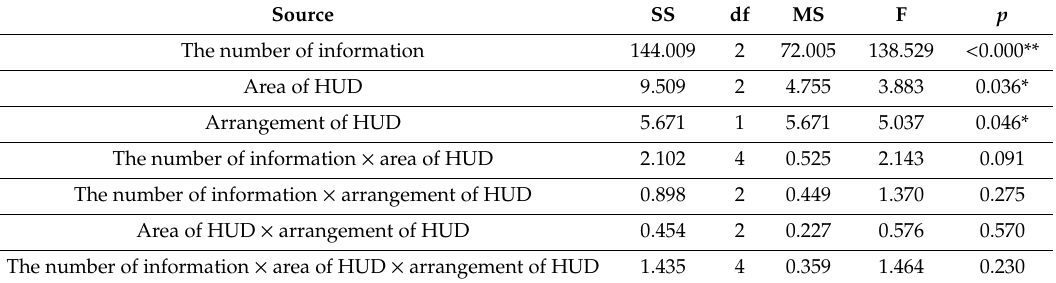
Table 4. RM-ANOVA results for subjective